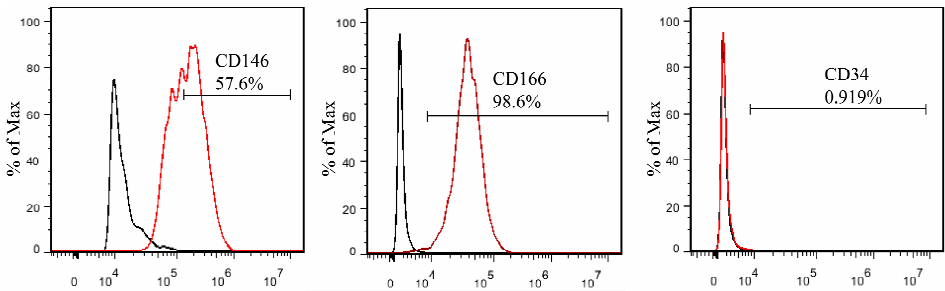
Figure 5. Characterization of human periodontal ligament stem cells (PDLSCs). Single-cell colony formation ( A ); and cell adhesion and proliferation on a tissue culture plate ( B ); ( C , D ) Show vimentin/nuclei and cytokeratin/nuclei staining; ( E ) Osteogenic differentiation (alizarin red staining) and ( F ) adipogenic differentiation (oil red O staining). Immunophenotype expression results from flow cytometric analysis ( G ).